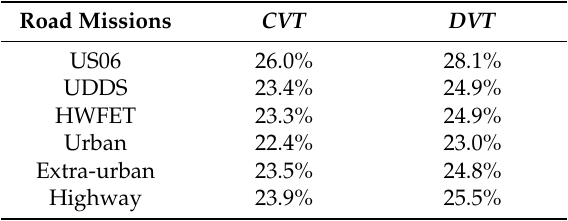
Table 4. Powertrain efficiency over different road